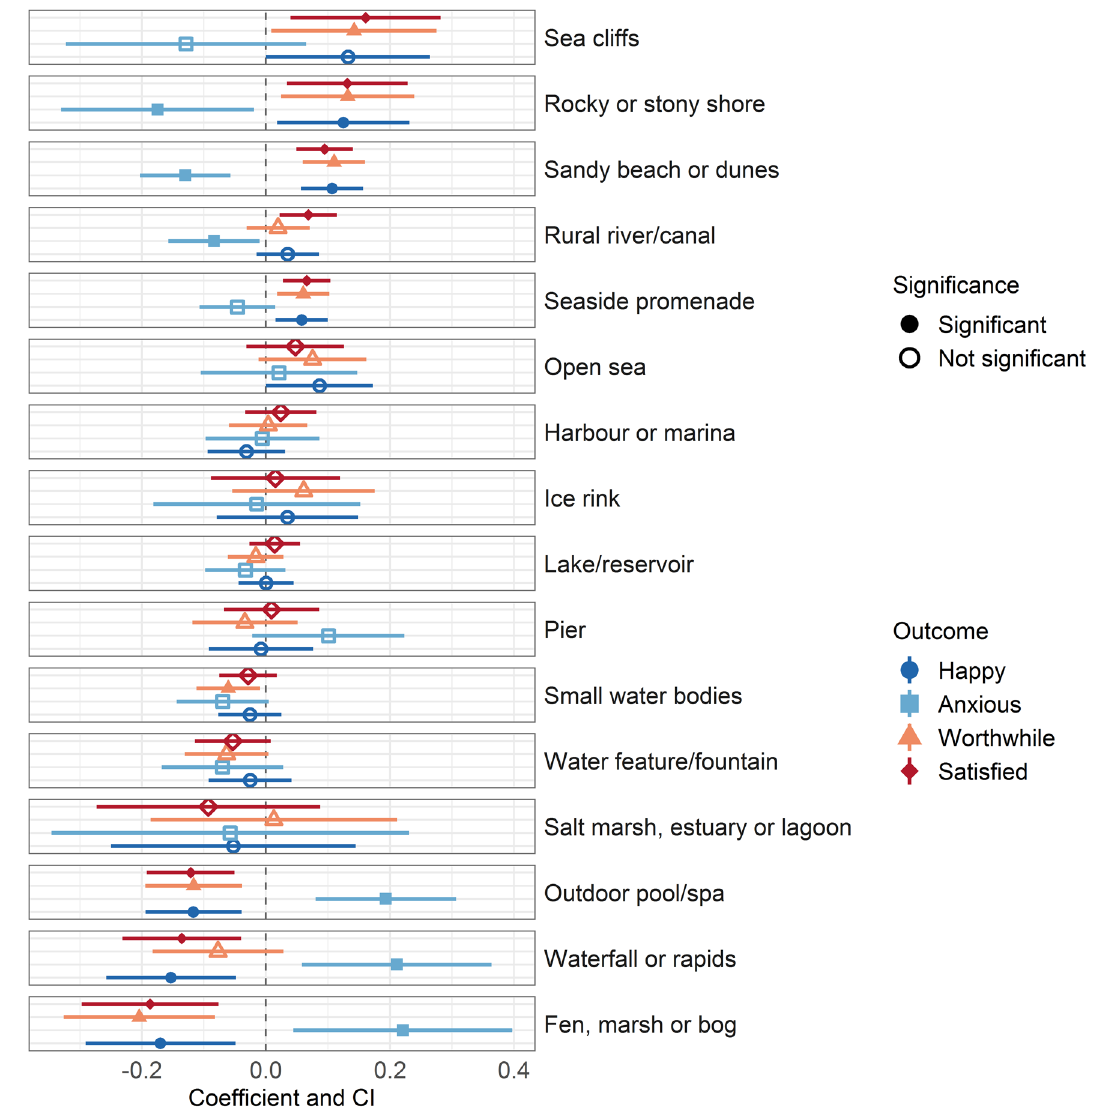
Figure 2. Well-being outcomes associated with bluespace type. Fully adjusted linear model (Step 3) coefficients and 95% confidence intervals, associated with each bluespace type and well-being outcome in comparison to the overall mean. Significance (at p < 0.05) can be observed where the 95% CI does not cross 0 (displayed with a dashed horizontal line). Note that negative coefficients for anxiety are associated with better levels of visit anxiety compared to the grand mean, and, of these, sunbathing/paddling and quiet activities were also associated with significantly higher levels of visit happiness than the grand mean (Tables 1, S4–S7). No significant differences in mental well-being outcomes compared to the grand mean were found for fishing, watersports, cycling, swimming or visiting an attraction. Overall, variation in well-being outcomes as a function of activity type was greater than as a function of bluespace type. To analyse these relationships further, we visualised the combined effect of location and activity on happiness and anxiety. For robustness, we focused on activity-environment combinations with a minimum of 100 visits (excluding “other”) and predicted values of hedonic well-being in terms of happiness and anxiety based on the fully-adjusted models (Step 3) with covariates randomly drawn from the original distribution for visitor charac- teristics and fixed covariates for the remaining variables. These were plotted on axes of predicted happiness and anxiety, with origins of the axes set at the respective mean predicted values. The axis for visit anxiety is reversed so that, more intuitively, “better” well-being outcomes are displayed in the top right quadrant of the figure (Fig. 4). With the exception of playing with children at lakes or reservoirs, the visits in the top right quadrant are all located at coastal environments and included appreciating nature, swimming, walking with and without a dog, playing with children, socialising, and sunbathing/paddling. Playing with children consistently exhibited the highest levels of predicted happiness. Playing with children and sunbathing/paddling at a sandy beach were also associated with the least anxiety.